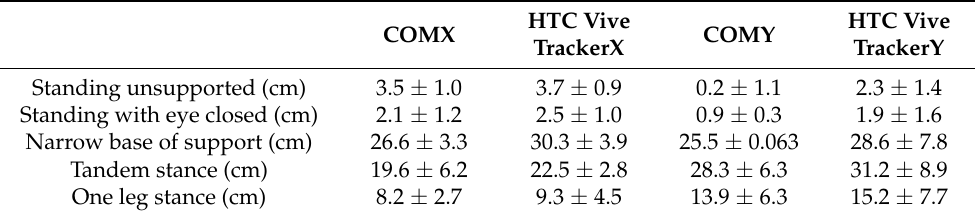
Table 3. Distance of the COM travelled in X- and Y-direction during the subsequent VR-BBS tasks in